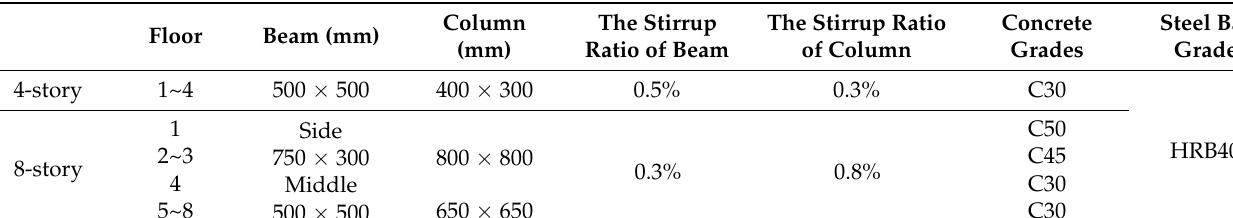
Table 7. Cross-section of beams and columns and material information.